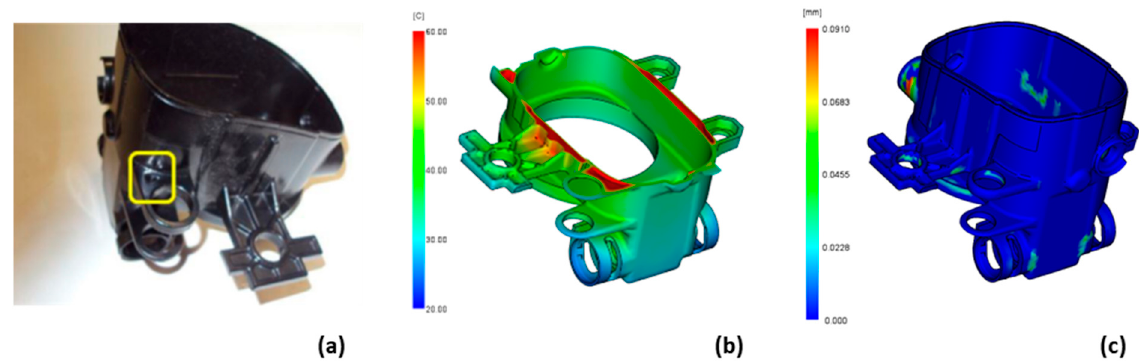
Figure 14. Sink mark due to material concentration on product ( a ) product temperature in the sink mark region ( b ) and sink mark prediction result ( c ).